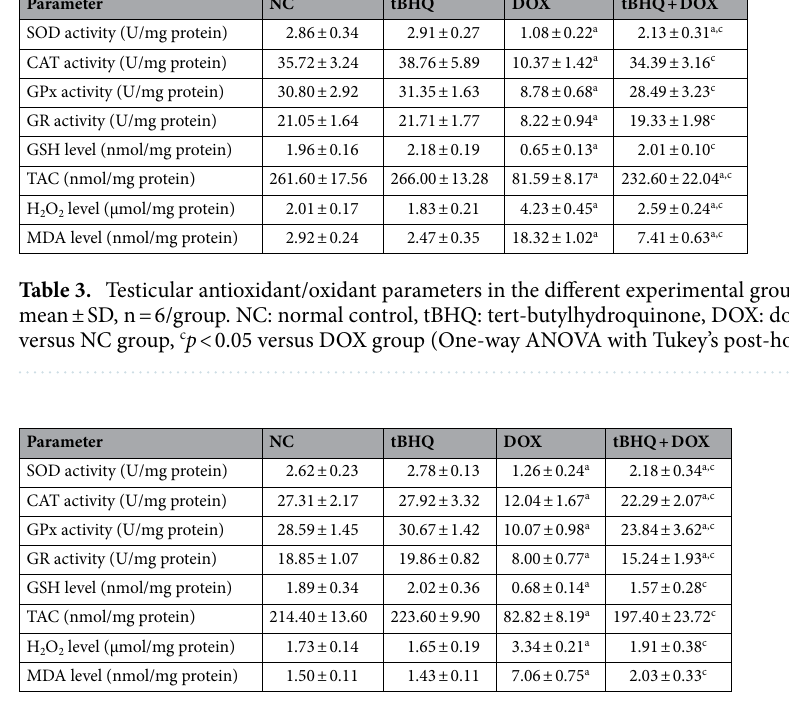
Table 4. Epididymal antioxidant/oxidant parameters in the different experimental groups. Values are mean ± SD, n = 6/group. NC: normal control, tBHQ: tert-butylhydroquinone, DOX: doxorubicin. a p < 0.05 versus NC group, c p < 0.05 versus DOX group (One-way ANOVA with Tukey’s post-hoc test).